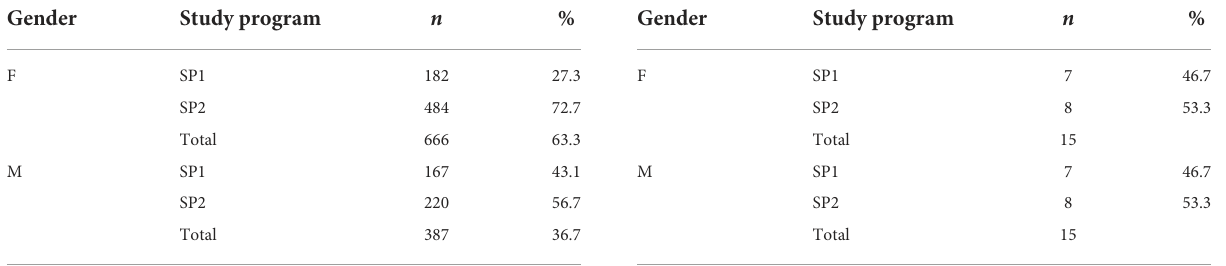
TABLE 2 Sample structure of respondents – survey. TABLE 3 Sample structure of respondents –